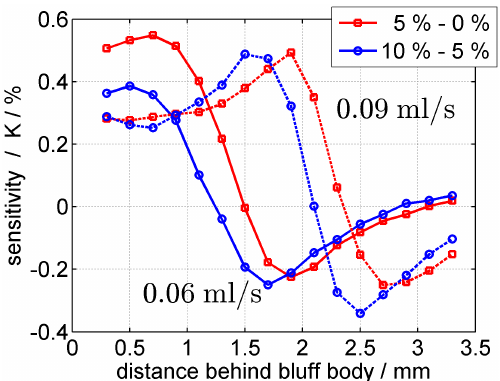
Figure 17. Length of the stationary vortex pair for different flow rates evaluated for three volume fractions of methanol in